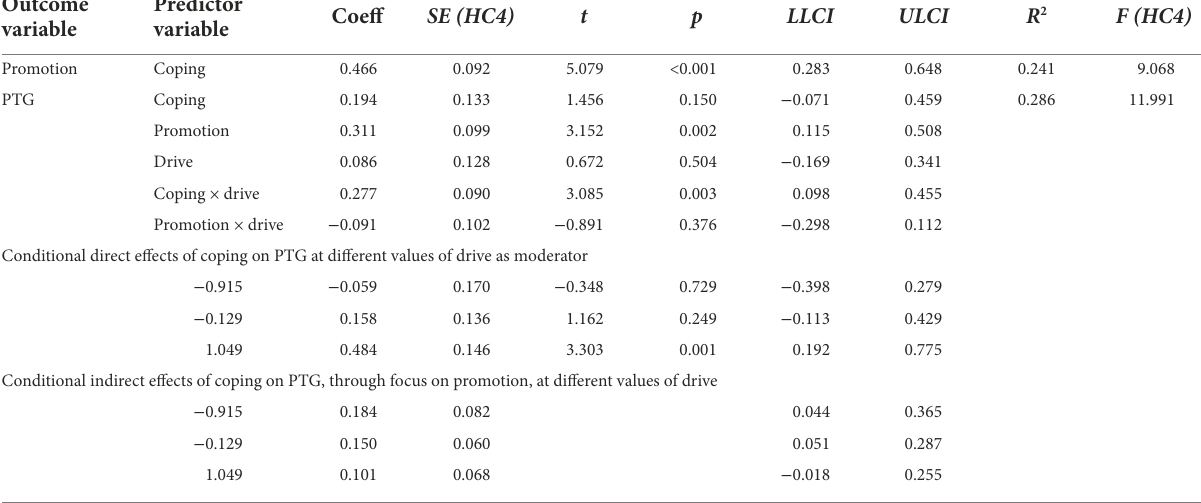
TABLE 3 Regression coefficients and confidence intervals of mediation analysis.